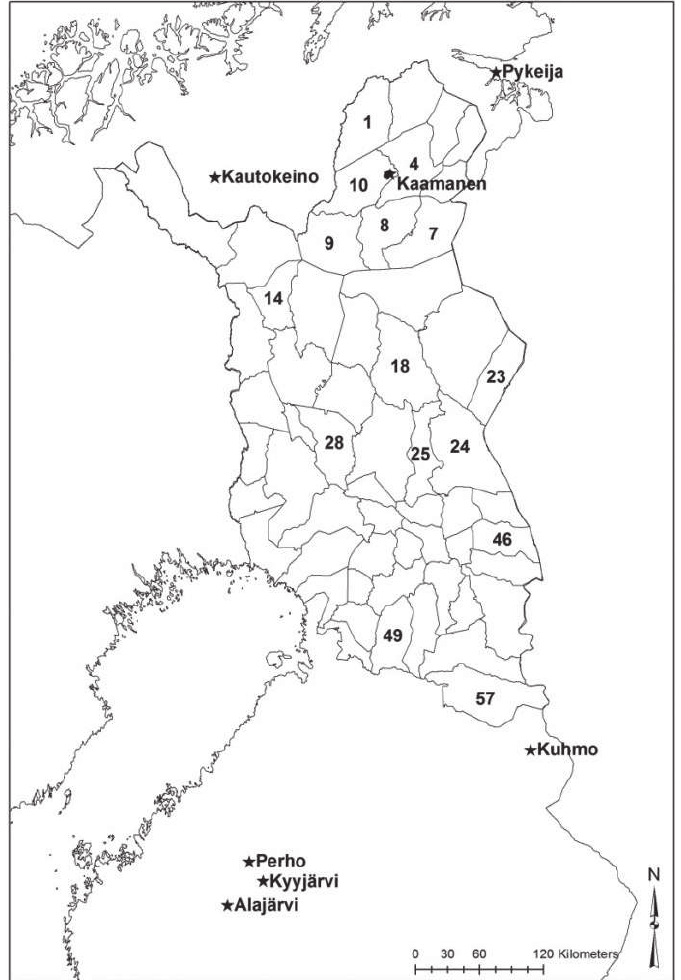
Fig.1. Study areas of wild forest